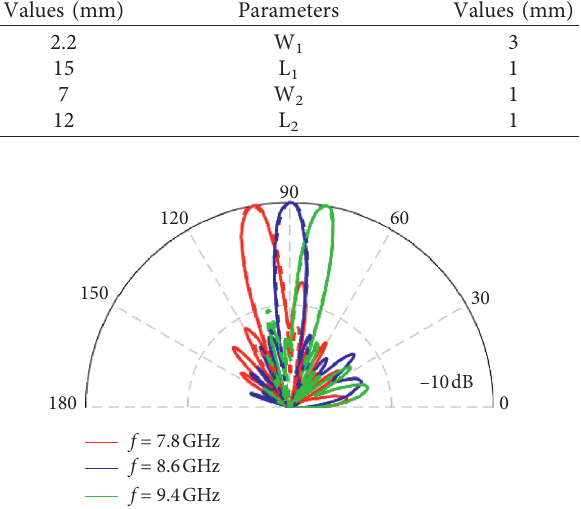
Figure 18: The measured radiation pattern of the proposed pe- riodic MLWA at the broadside (—— measured ---- simulated).